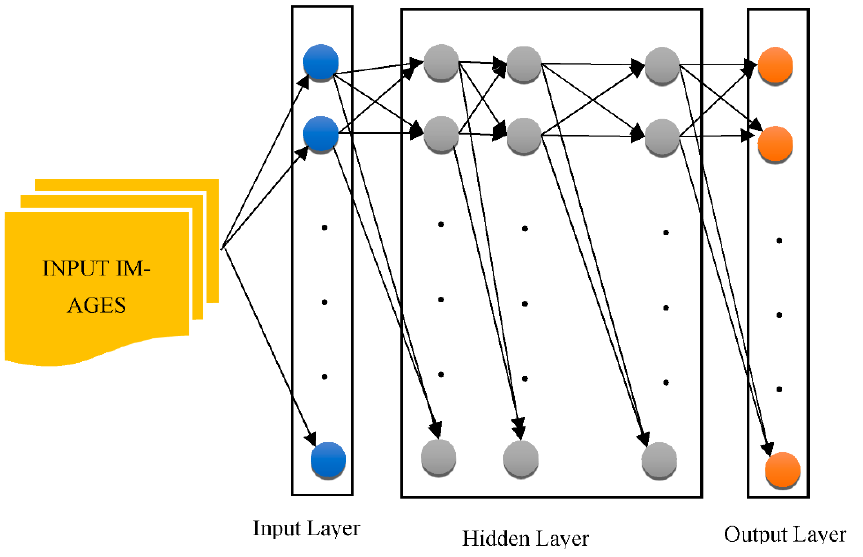
Figure 2. The architecture of a generalized CNN.